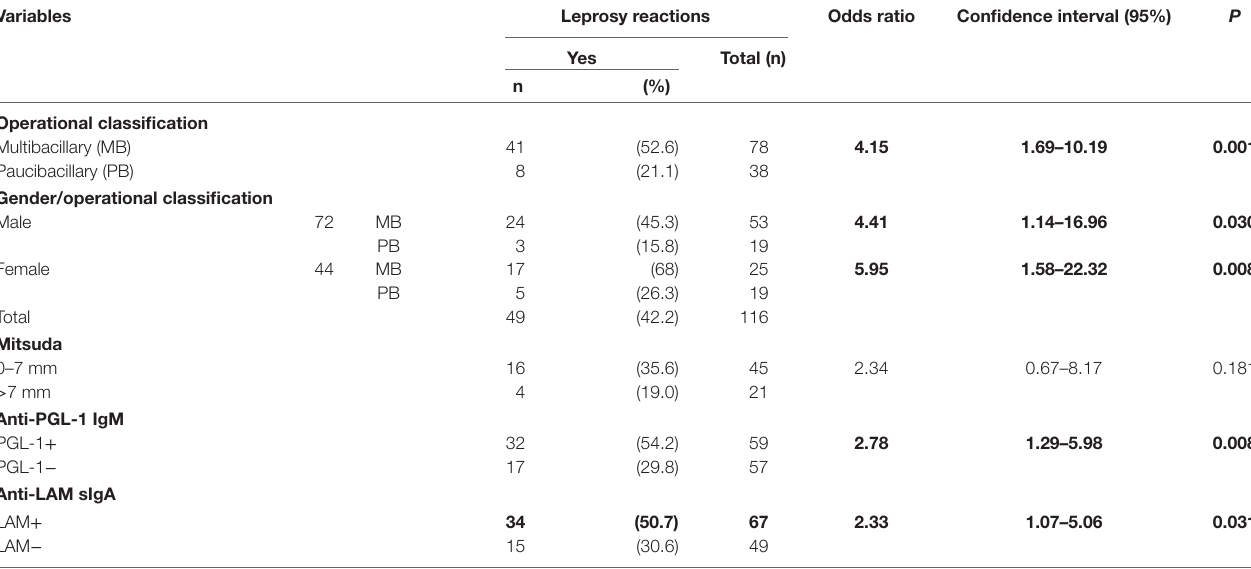
Table 1 | Frequencies of treatment naïve leprosy patients with or without reactions during or after MDT, divided according to their operational classification, gender, Mitsuda test result, anti-phenolic glycolipid 1 (PGL-1) IgM serology, and anti-lipoarabinomannan (LAM) sIgA in saliva, obtained at diagnosis.